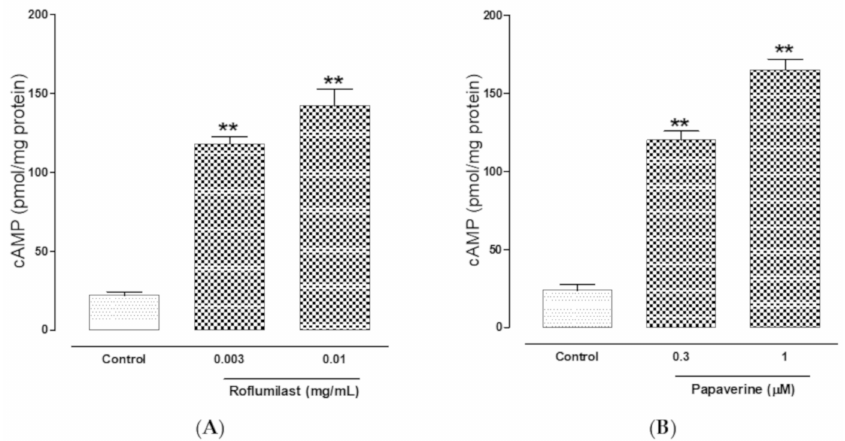
Figure 4. E ff ect of roflumilast ( A ) and papaverine ( B ) on the cAMP content of rabbit